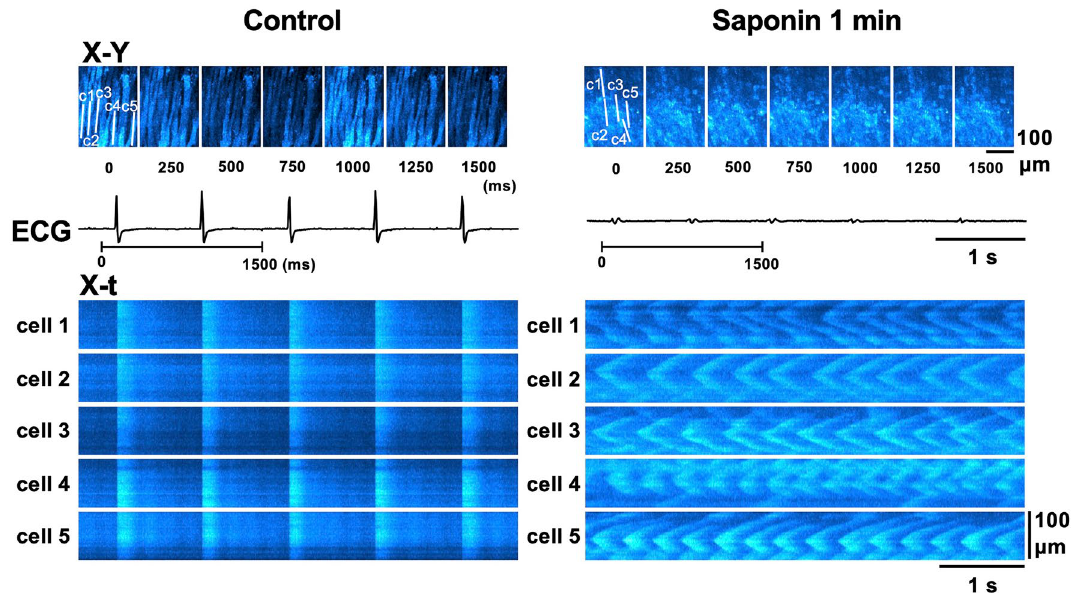
Figure 1. Development of high-frequency Ca 2+ waves in response to saponin treatment. Sequential X–Y images (top panels, taken every 250 ms) of the subepicardial regions in the left ventricular myocardium over a 1500-ms period as indicated by the horizontal lines below the electrocardiogram (ECG) under the control conditions (left) and 1 min after the introduction of the saponin treatment (right). The X-t images (lower panels) for the fluo4-fluorescence intensity of five different cardiomyocytes (cells 1–5) when evaluated along the c1–c5 lines (100 μm) identified in the top